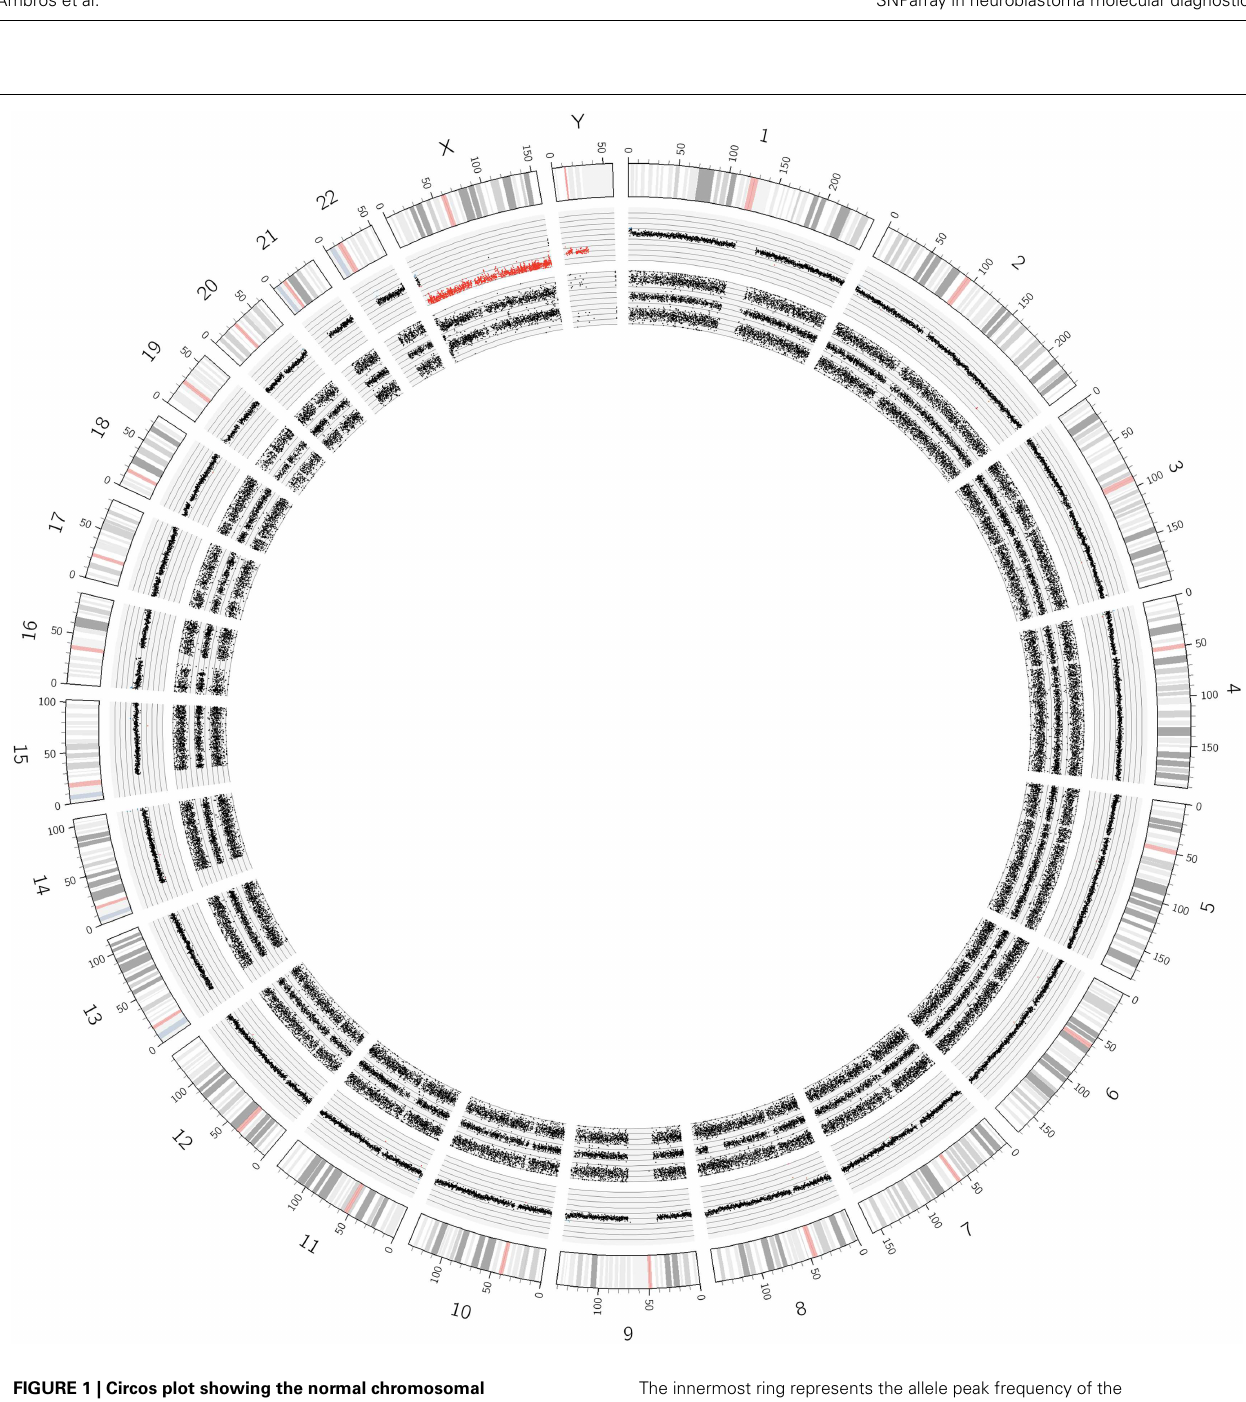
The innermost ring represents the allele peak frequency of the chromosomes. All autosomes disclose three allele peak tracks whereas the X andY chromosomes show only two tracks; exception: the pseudo-autosomal regions on the tips of the X chromosome, which have three allele